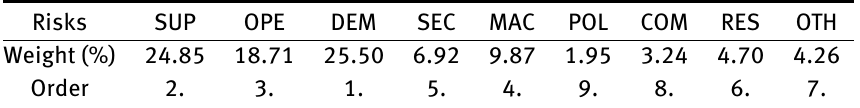
Table 2: Resulting Risks